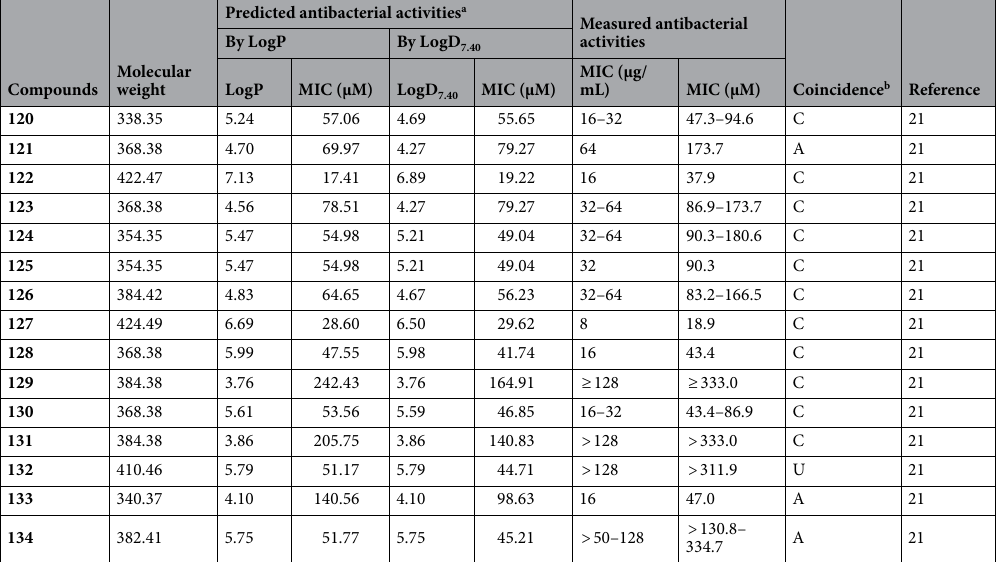
Table 8. Comparison of predicted and reported antibacterial activities of some flavonoids. Antibacterial activities were expressed as MICs of flavonoids to gram-positive bacteria which include S. aureus , S. epidermidis and B. subtilis. a LogP and LogD 7.40 were calculated using software ACD/Labs 6.0. b C, Complete coincidence; A, Acceptable; U,